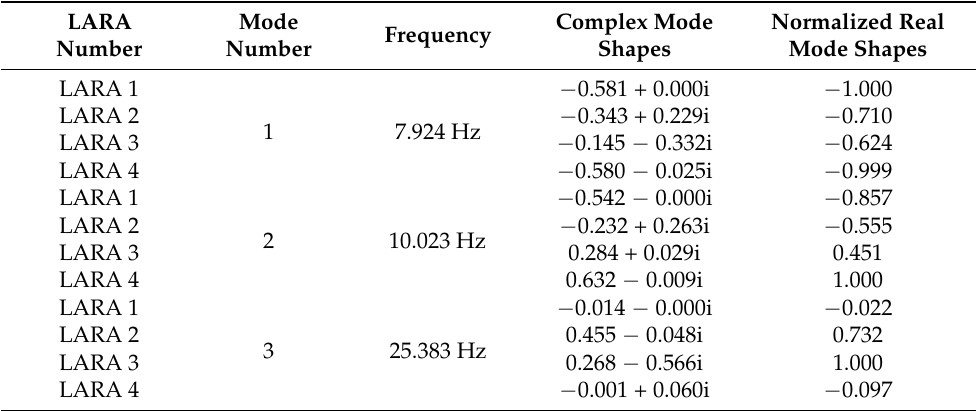
Table 7. Modal analysis output of the FDD application for the four low-cost